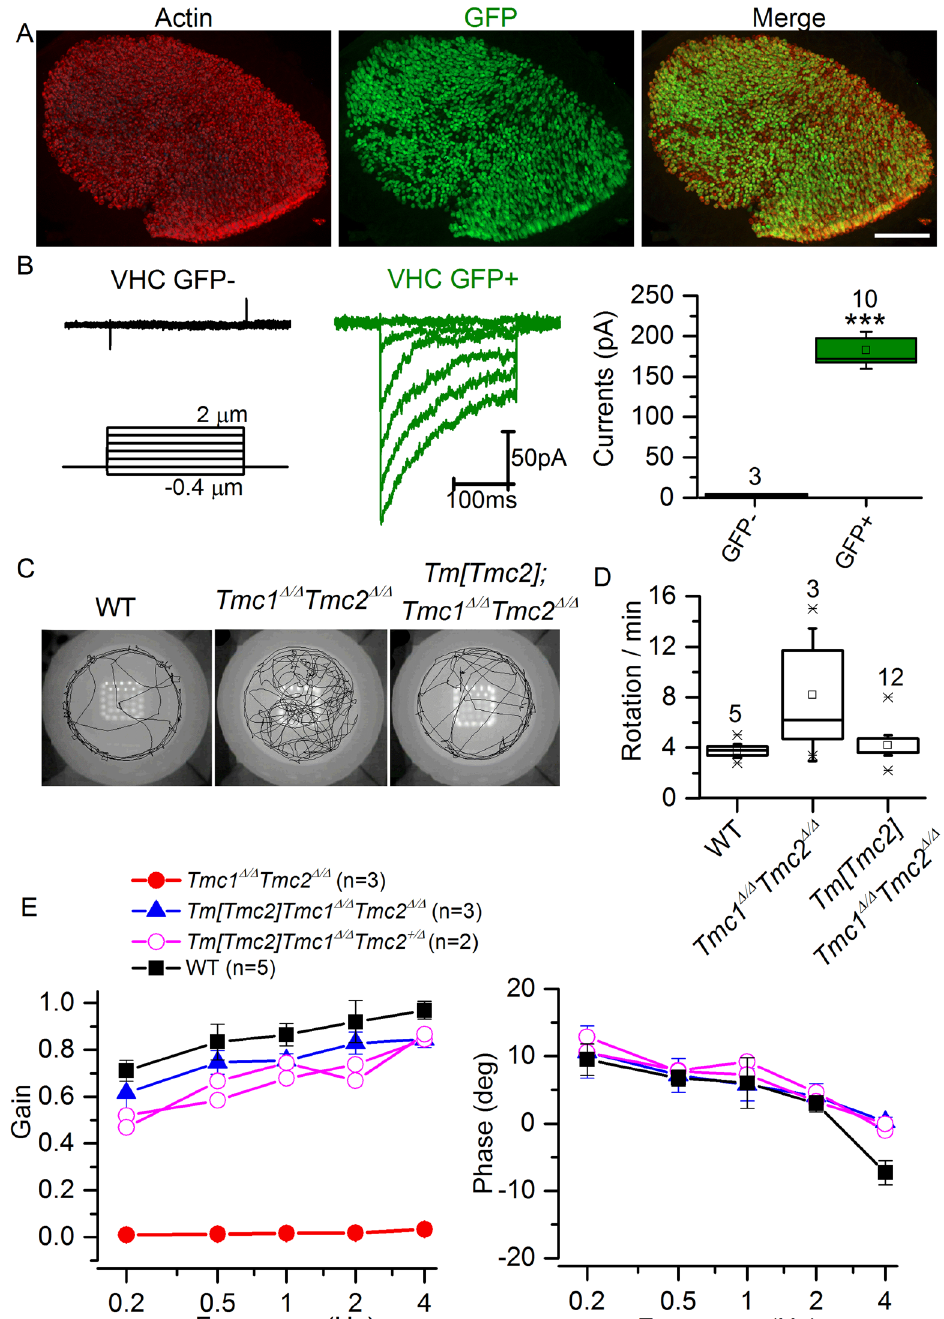
Figure 8. Recovery of sensory transduction and balance function with Tm [ Tmc2 ]. ( A ) Gfi1 cre recombination in Rosa26 tm ( CAG-LSL-Tmc2-IRES-GFP ) leads to GFP expression in hair cells of the utricle, here shown at P8 in Tmc1 Δ / Δ Tmc2 Δ / + . Red: Actin-phalloidin; Green: GFP. Scale bar: 100 μ m. ( B ) Sensory transduction is absent from GFP-negative cells but robust in GFP-positive cells in P3-P6 utricles of Gfi1 cre recombined mice under Tmc1 Δ / Δ Tmc2 Δ / Δ background. ( C ) Expression of Tm [ Tmc2 ] decreases circling behavior that is detected in absence of Tmc1 and Tmc2 . Open field observations were performed for 5 min in 4 weeks old wild type C57BL6 (WT), Tmc1 Δ / Δ Tmc2 Δ / Δ , and Tmc1 Δ / Δ Tmc2 Δ / Δ expressing Tm [ Tmc2 ] after Gfi1 cre recombination. Representative tracks over 2.5 min are shown. While Tmc1 Δ / Δ Tmc2 Δ / Δ mice explore the entire field and perform repetitive full body rotations, Tm [ Tmc2 ] ; Tmc1 Δ / Δ Tmc2 Δ / Δ mice demonstrate normal behavior similar to wild type controls. ( D ) Rotations were reduced in Tmc1 Δ / Δ Tmc2 Δ / Δ expressing Tm [ Tmc2 ]. The box plot illustrates the mean ± S.D. and median value for the number of rotations covered per minute for each genotype. ( E ) Rotational VOR responses to sinusoidal head rotation were recovered in Tmc1 Δ / Δ Tmc2 Δ / Δ expressing Tm [ Tmc2 ]. Gains and phases are plotted as functions of head rotation frequency for each group. Mean ± S.E.M for groups that have 3 or more mice. Pink lines with hollow circles in panel E represent individual animals due to sample size = 2. *** P < 0.001 (one way